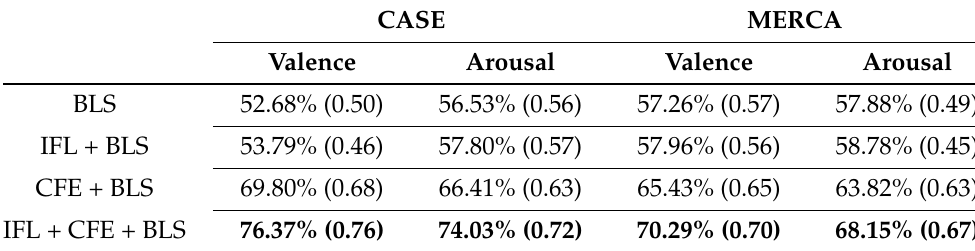
Table 6. Ablation study of different components in CorrNet (accuracy